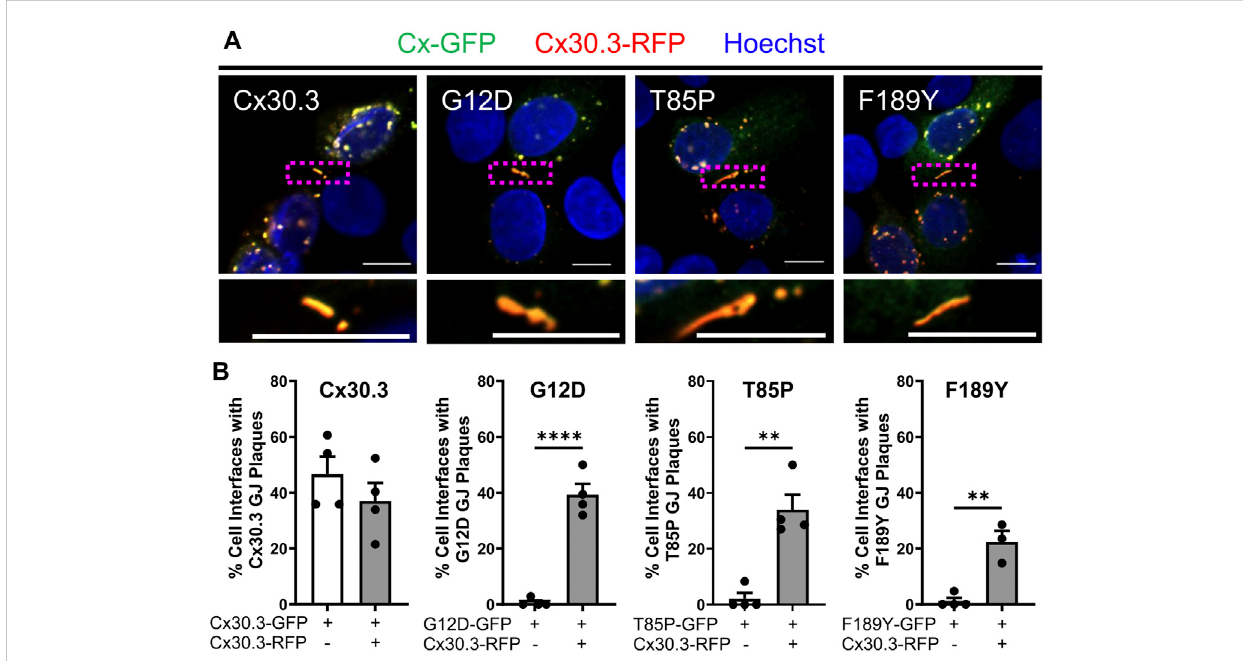
FIGURE 8 Co-expression of wild type Cx30.3 restores Cx30.3 mutant traf fi cking and assembly into gap junctions. (A) Representative images of Cx43KO REKs co-expressing GFP-tagged wild type or Cx30.3 mutants (green) and RFP-tagged wild type Cx30.3 (red). Yellow/orange signal denotes regions of overlapping red and green signals. Dashed boxes indicate the areas magni fi ed in the inserts below. Nuclei counterstained with Hoechst 33342 (blue). Scale bars = 10 µm. (B) Expression of wild type Cx30.3 signi fi cantly increased the incidence of gap junctions containing Cx30.3 mutants in (cid:129) ) represent one replicate. ** p < 0.01; **** p < keratinocytes. Filled in circles (